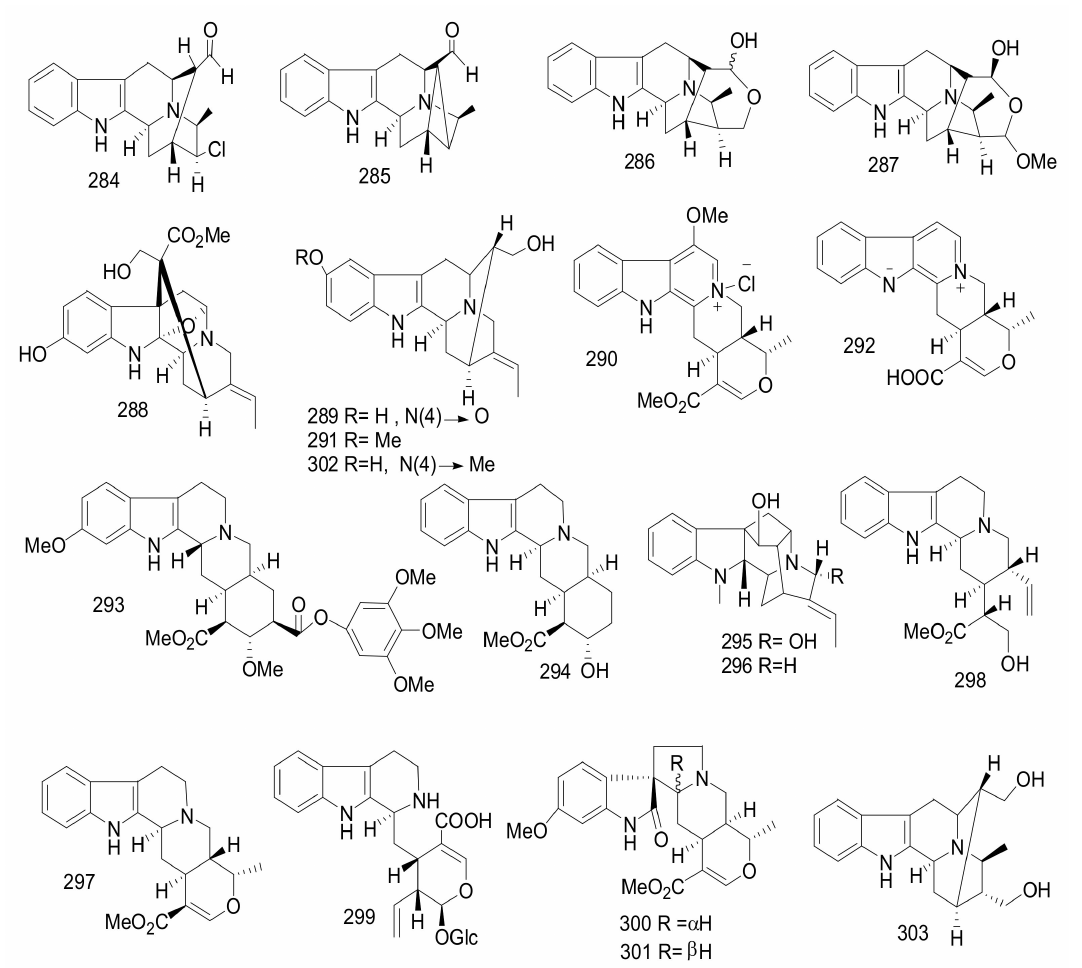
Figure 24. Compounds 284 – 303